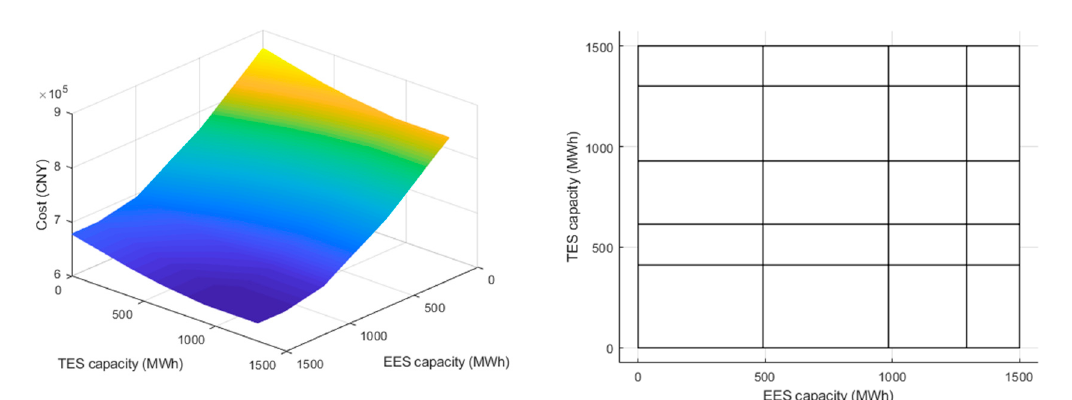
Figure 3. OVF and critical regions with different solar capacities.